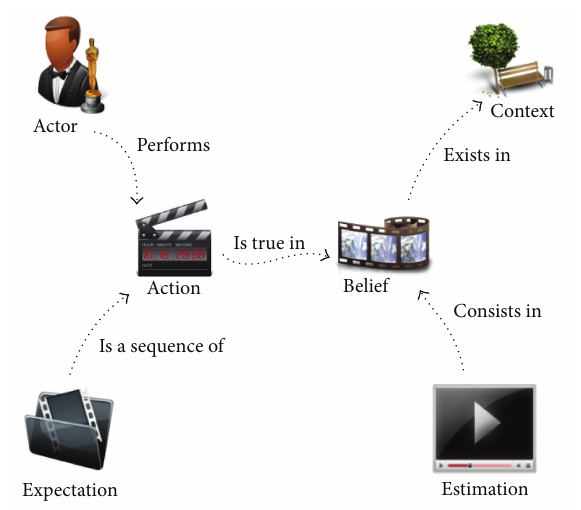
Figure 1: A semantic model for video-based human action